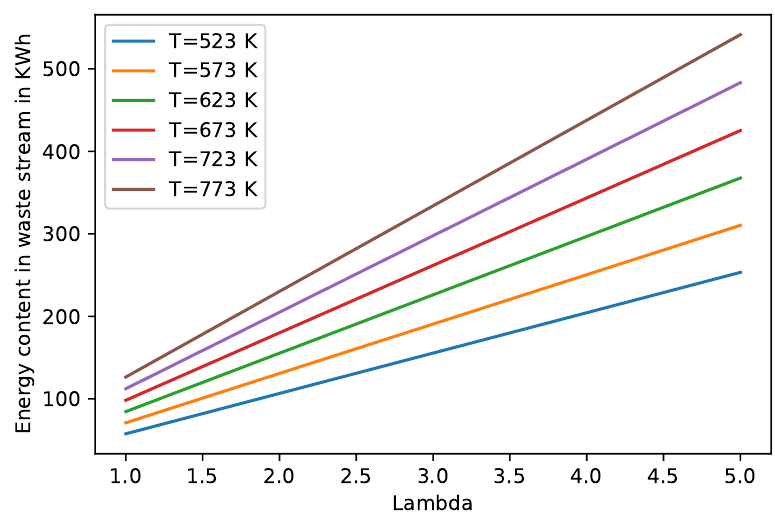
Figure 10. Waste gas enthalpy variation with temperature and mass flow rate of input hydrogen.